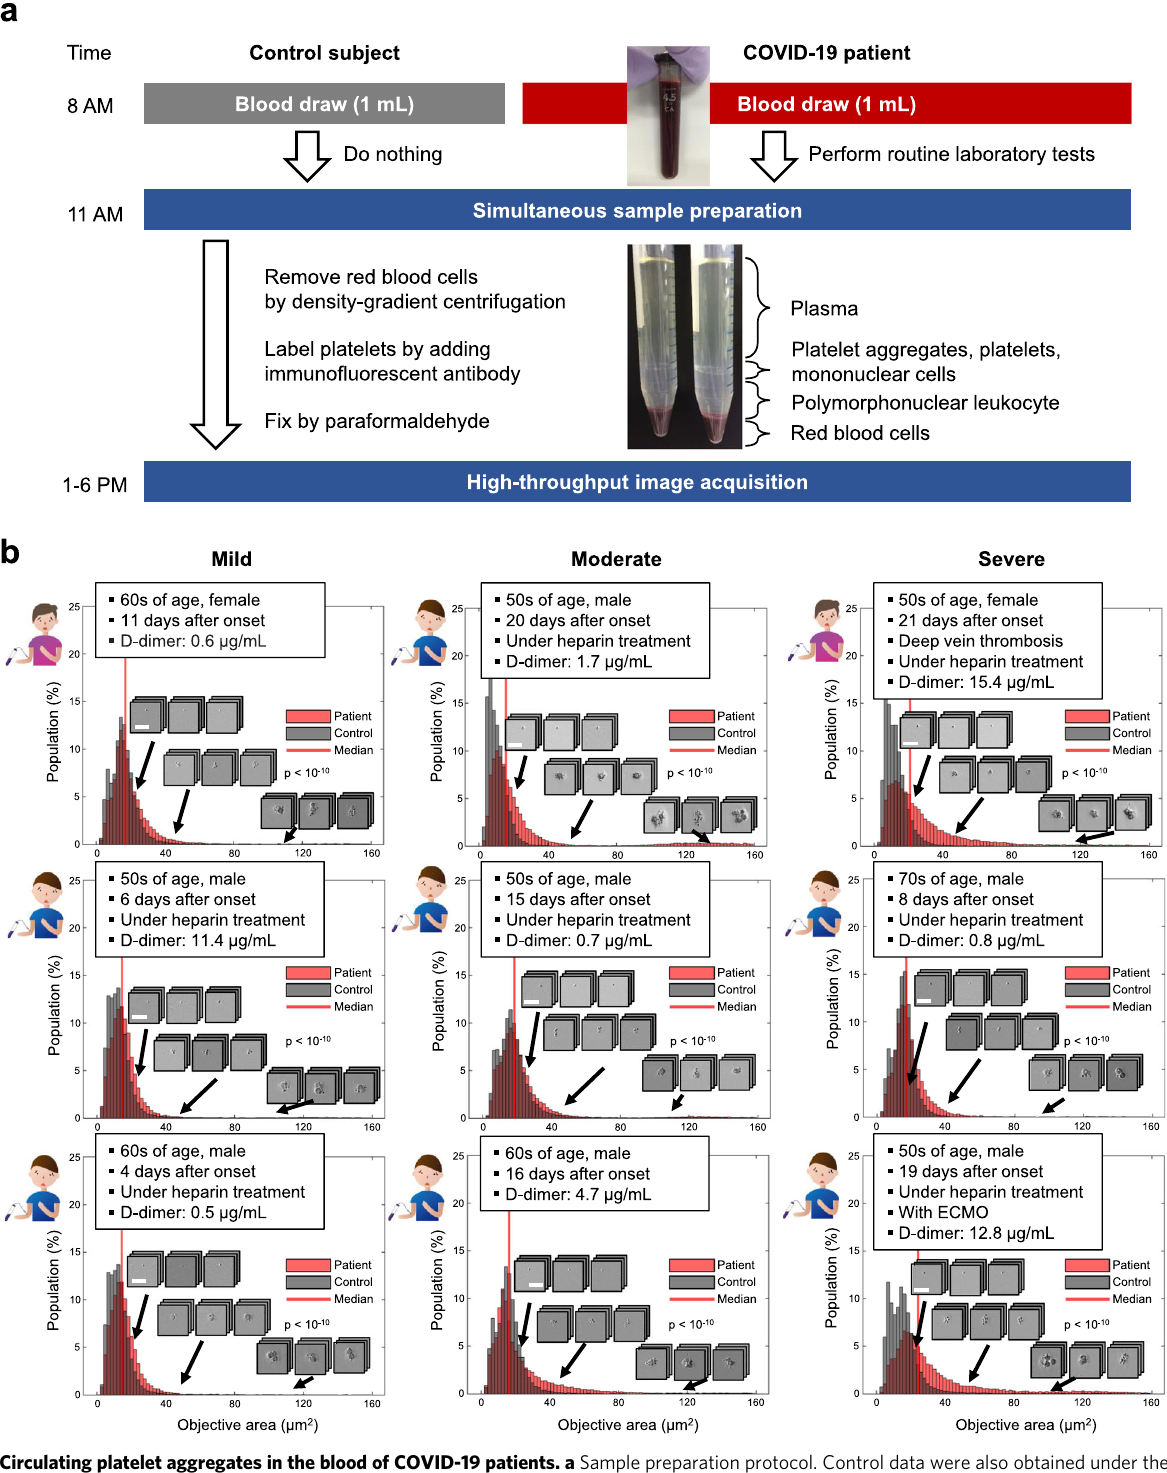
Fig. 2 Circulating platelet aggregates in the blood of COVID-19 patients. a Sample preparation protocol. Control data were also obtained under the same sample preparation and image acquisition conditions on the same day to mitigate potential bias in the image data that may have come from experimental variations in blood draw, sample preparation, optical alignment, and hydrodynamic focusing conditions. See “ Sample preparation ” in the Methods section for details of the protocol. b Size distribution histograms and typical images of single platelets and platelet aggregates in the blood of mild, moderate, and severe patients with COVID-19. Scale bar: 30 µ m. The clinical information and D-dimer level of each patient are also shown in the insets. Control data are also shown as references. P values were obtained using the Wilcoxon rank-sum test (two-sided) and shown in the fi gure. Source data are provided as a Source Data fi